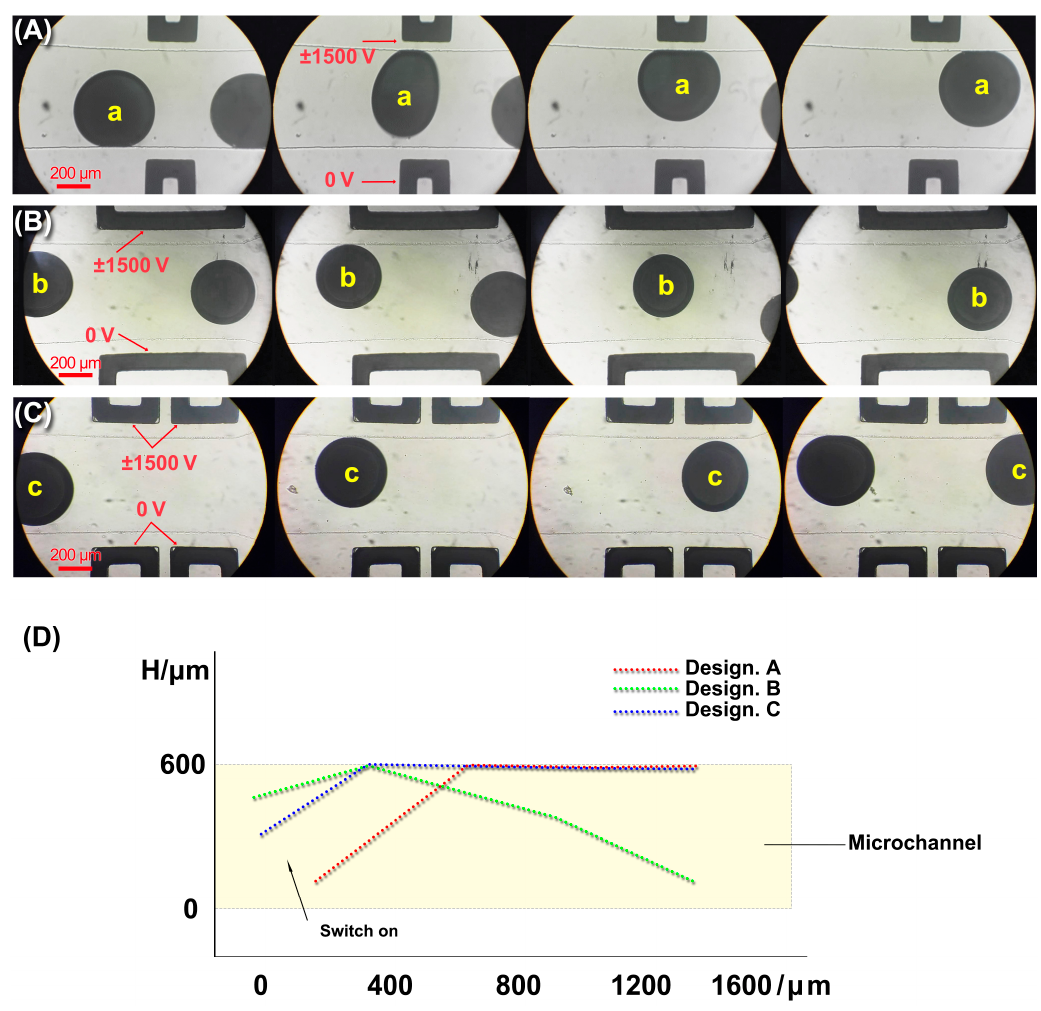
Figure 5. Liquid metal droplet sorting with three different patterns of electrodes; ( A ) Design A; ( B ) Design B; ( C ) Design C; ( D ) Droplet moving paths in Design ( A – C ).